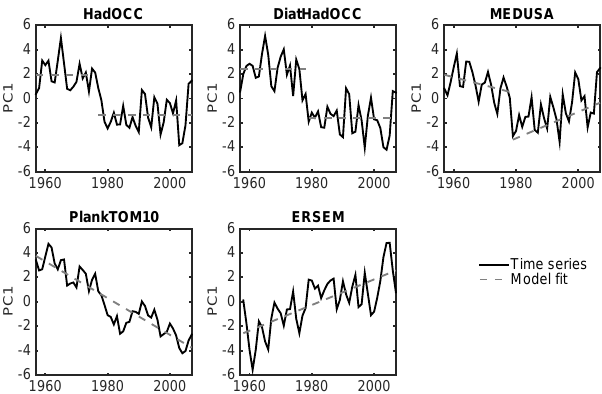
Figure 4. First principal component (PC1) of sea surface tempera- ture, mixed-layer depth, surface dissolved inorganic nitrogen, silica, iron, surface chlorophyll, integrated primary production, total sur- face phytoplankton and zooplankton biomass (if available) averaged over the Gulf of Alaska for each model. The grey dotted lines rep- resent the statistical model chosen to fit these time series (see Table 3). HadOCC, DiatHadOCC and MEDUSA PC1 exhibit a significant shift in the late